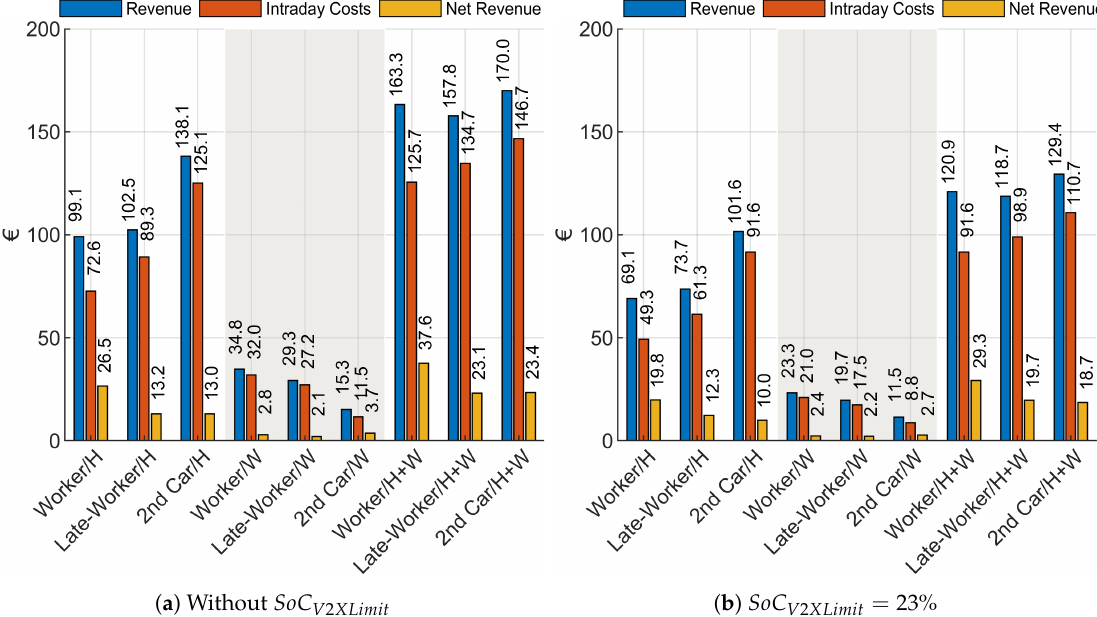
Figure 14. Revenue of aFRR provision, Intraday costs, and Net Revenue for FRR